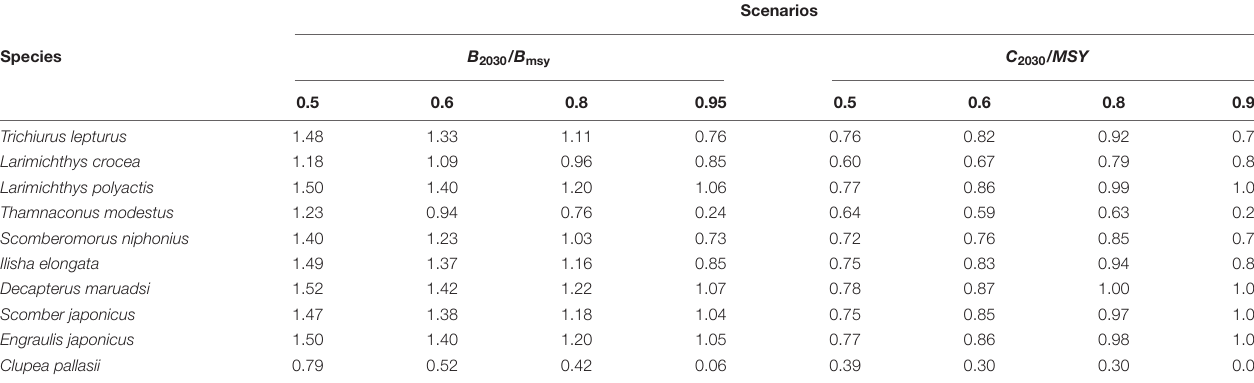
TABLE 3 | The predicted fishery biomasses and catch recoveries in 2030 under four exploitation scenarios (i.e., F = 0.5, F msy , 0.6 F msy , 0.8 F msy , and 0.95 F msy ).